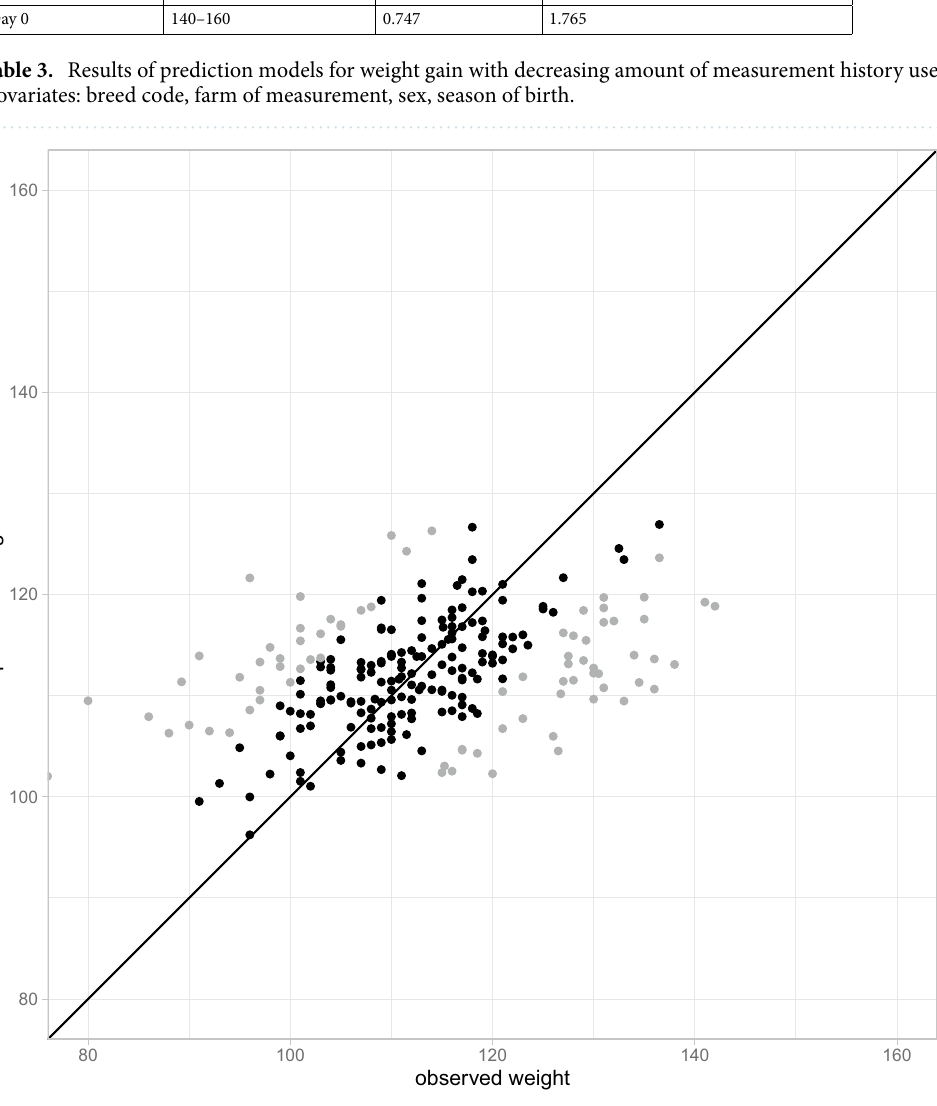
Figure 8. Observed weights against the predicted weight at day 160 from observations at day 0 and day 14 for 241 test piglets. Black dots indicate the observed weights within the 50% prediction interval of the predicted